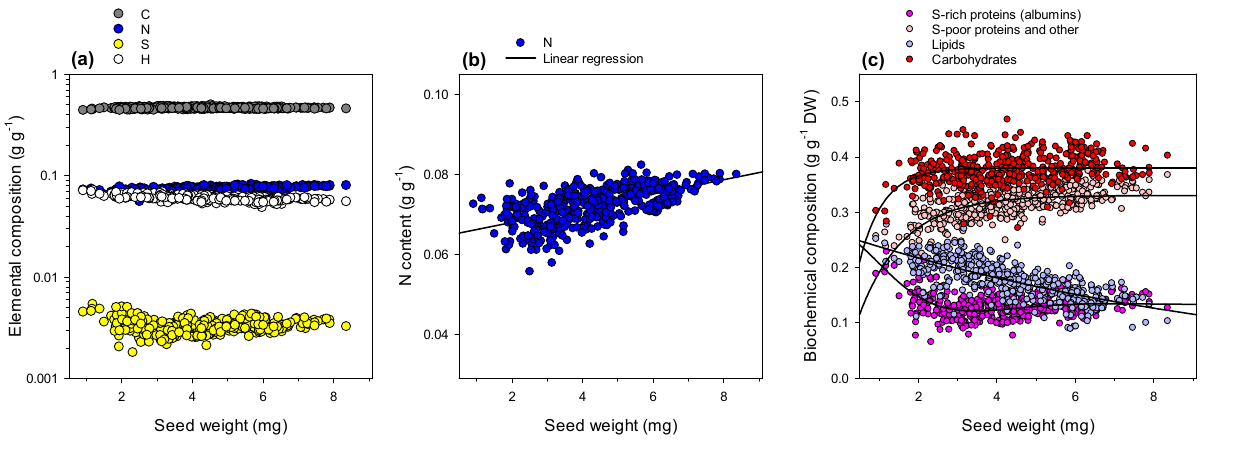
Figure 1. Seed composition. Elemental composition ( a ) measured by elemental analysis, in carbon, nitrogen, sulphur and hydrogen, in mass fraction (note the logarithmic scale to make the four elements of interest more easily visible). ( b ) Magnification of the relationship between N content and seed weight. The black line stands for a linear regression ( R 2 = 0.36, p < 0.001). ( c ) Biochemical composition in proteins, lipids and carbohydrates calculated from elemental composition. Thick black lines stand for exponential trends, exponential decay or raise to maximum (in all cases, R 2 > 0.96, p < 0.0001). In ( c ), major compounds considered are S-rich proteins (albumin type), other nitrogenous compounds (including S-poor proteins, such as vicilins and legumins), total lipids and carbohydrates (both struc- tural and non-structural). Elemental data are plotted against accessions in Supplementary Figure